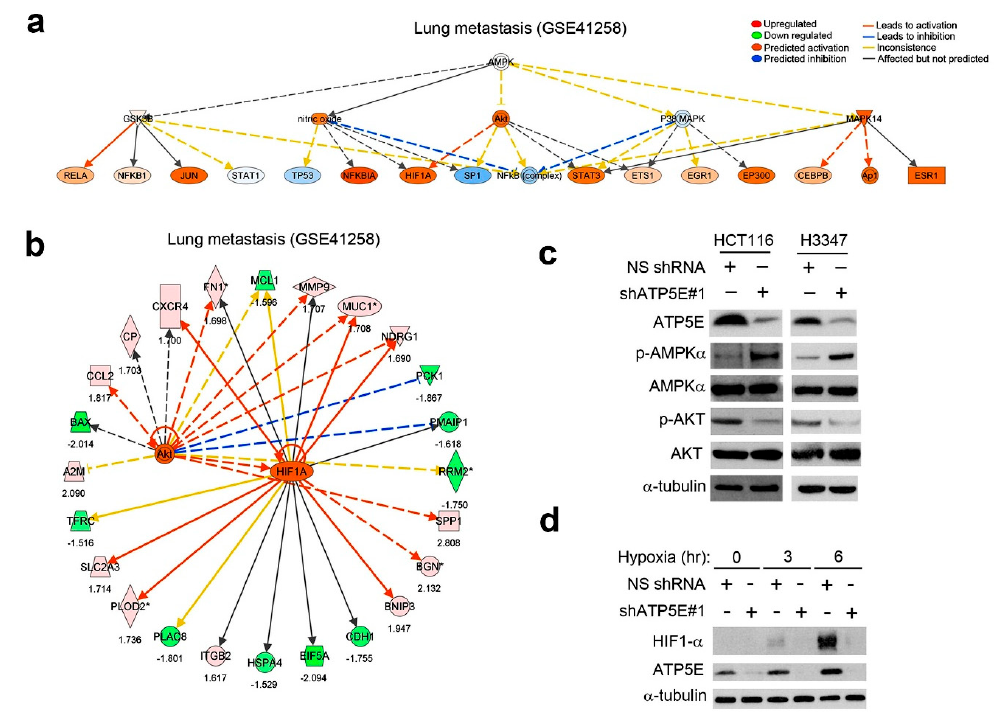
Figure 4. ATP synthase epsilon subunit (ATP5E) upregulation connects the adenosine monophosphate-activated protein kinase (AMPK)-AKT-hypoxia-inducible factor-1 α (HIF1a) signaling axis to the epithelial-to-mesenchymal transition (EMT) phenotype in lung metastatic tumors. ( a ) Upstream regulator analysis of differentially expressed genes in lung metastatic tumors from the GSE41258 dataset. The orange circle indicates predicted activation, while the blue circle indicates predicted inhibition. ( b ) Differentially expressed genes downstream of AKT and HIF1a extracted from the GSE41258 dataset. ( c ) Western blot analysis of the phosphorylation status of AMPK and AKT upon ATP5E inhibition in HCT116 and H3347 cells. ( d ) Western blot analysis of the HIF1a protein upon ATP5E inhibition in hypoxia.